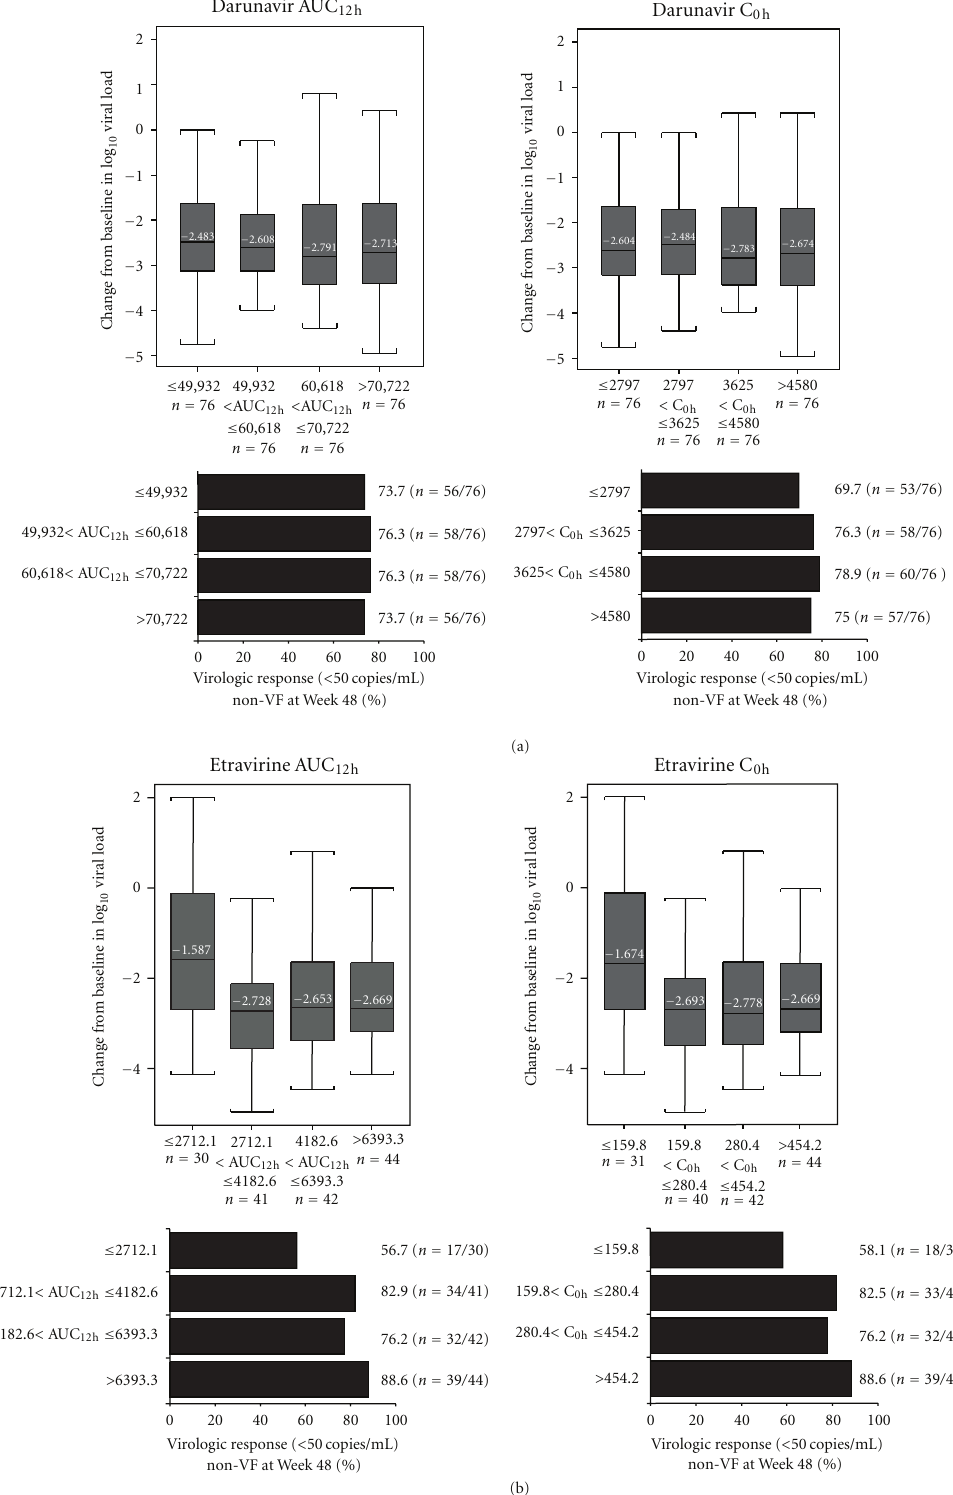
Figure 1: Change in log 10 viral load from baseline to Week 48 (nonvirologic failure censored) and virologic response by quartile ranges of (a) darunavir AUC 12h and C 0h (sparse pharmacokinetic sampling; n = 376) and (b) etravirine AUC 12h and C 0h (sparse pharmacokinetic sampling; n = 190). In Figures 1(a) and 1(b), the numbers within the boxplots represent the median values, the boxes represent the 25th and 75th percentiles, and the whiskers represent the highest and lowest value within 1.5 interquartile range. AUC 12h : area under the plasma concentration–time curve over 12 hours; C 0h : trough concentration; DRV: darunavir; non-VF: nonvirologic failure censored population; ETR: